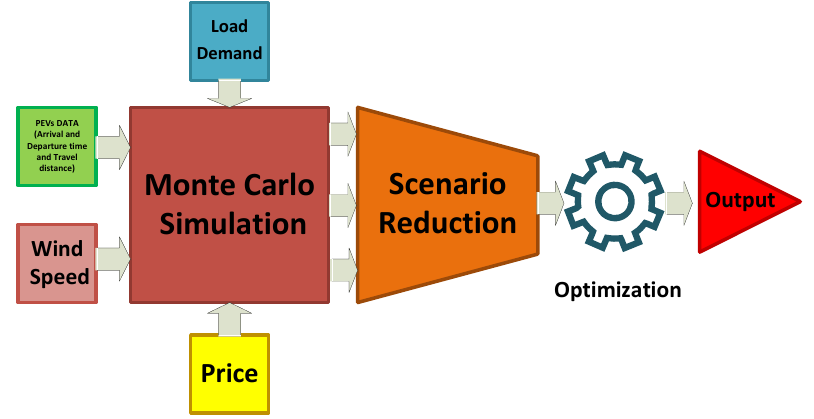
Figure 1. Plug-in electrical vehicles (PEVs) modelling and optimization procedure.